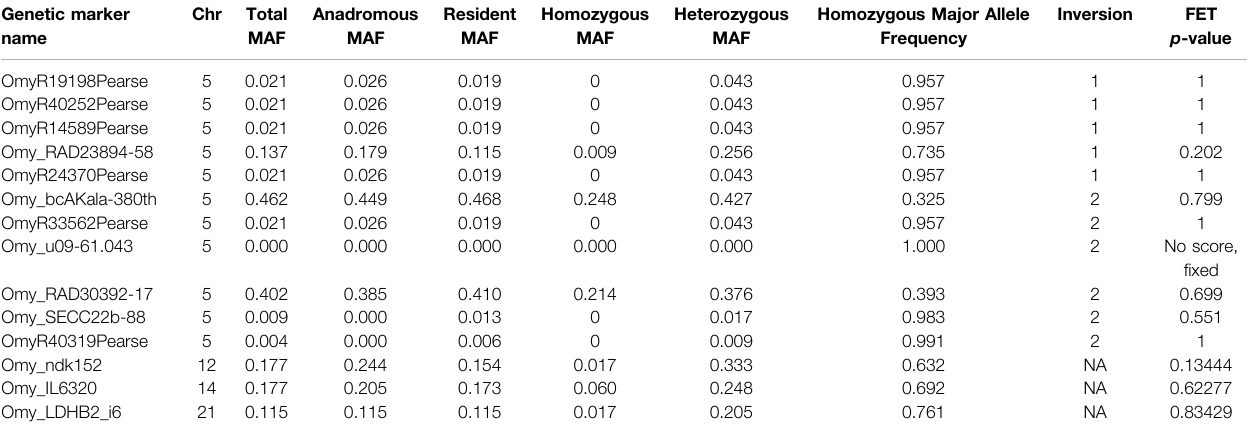
TABLE 2| Chromosome(Chr)Omy05markersfrom Pearseetal.(2019)andcandidategeneticmarkersfromNarum etal.(2011)wereanalyzed withminor allelefrequencies (MAF) and Fisher's Exact Test (FET) for the samples for this study. Genetic marker name